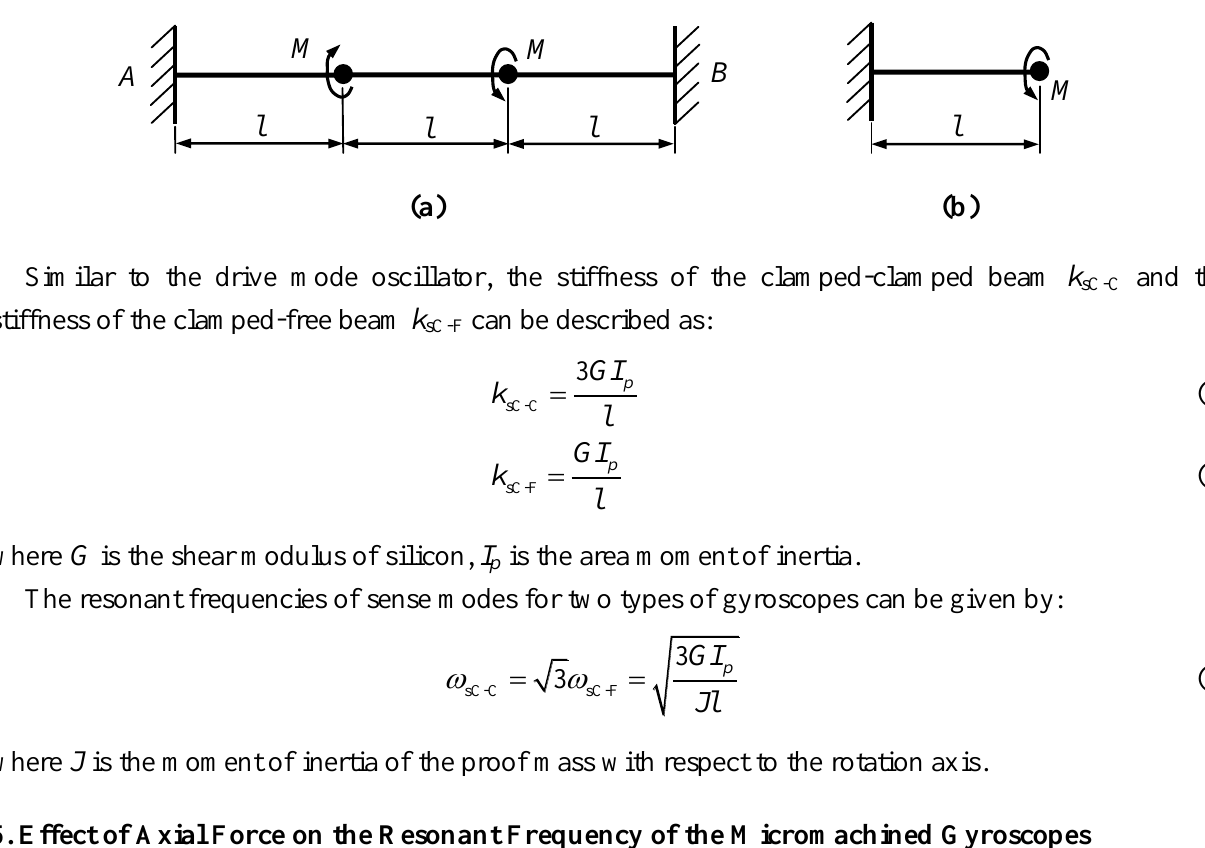
Figure 6. Kinematic analysis of the sense mode: torsional vibration of the slanted beam. ( a ) clamped-clamped ( b )